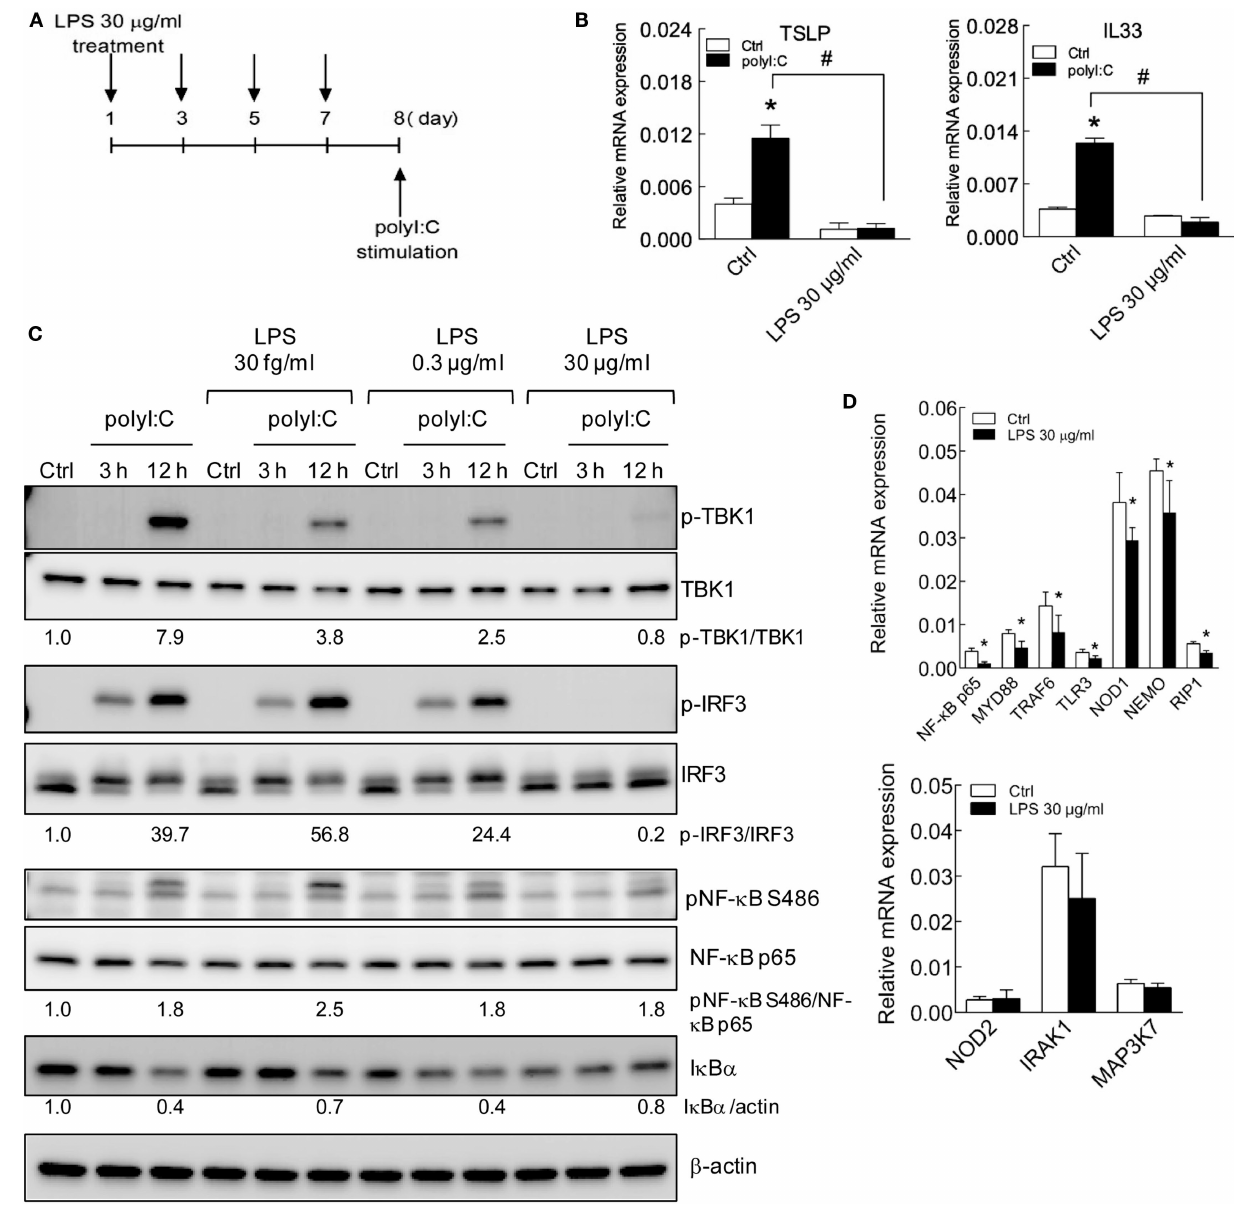
FigUre 6 | TslP and il33 induction is impaired in h292 cells with long-term lPs exposure . (a) The schematic shows long-term LPS treatment of H292 cells. H292 cells were stimulated with LPS 30 μ g/ml for 8 days, then with polyI:C (2.5 μ g) for 3 h. (B) RT-qPCR analysis of mRNA levels of polyI:C-induced TSLP and IL-33 in H292 cells with long-term LPS (30 μ g/ml) treatment. (c) H292 cells were treated with various doses of LPS for 8 days, then stimulated with polyI:C (2.5 μ g) for 3 h. Immunoblotting analysis with the indicated antibodies. The ratio of signaling protein expression was normalized to medium control. Results are representative of three independent experiments. (D) RT-qPCR analysis of TLR signaling gene expression in H292 cells with long-term LPS treatment. Data are mean ± SD from three independent experiments. * P < 0.05 compared to control; # P <